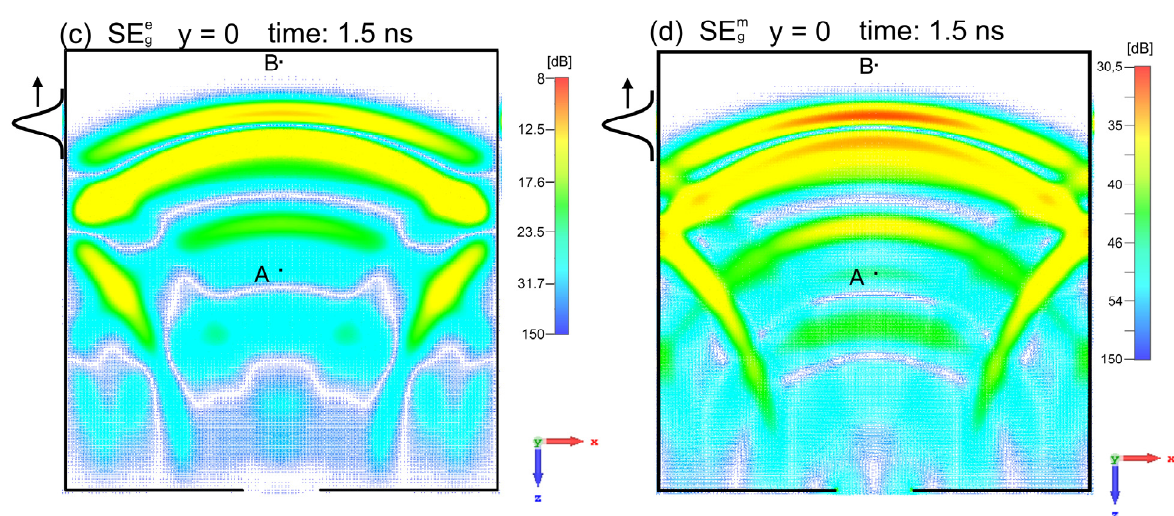
Figure 12. Global SE g maps of the shielding effectiveness (the electric SE e g and magnetic SE m g ) at times t = 0.96 ns and t = 1.5 ns in the plane y = 0. The case of the wave phase. The position of the incident EM pulse is shown on the left side of the enclosure.